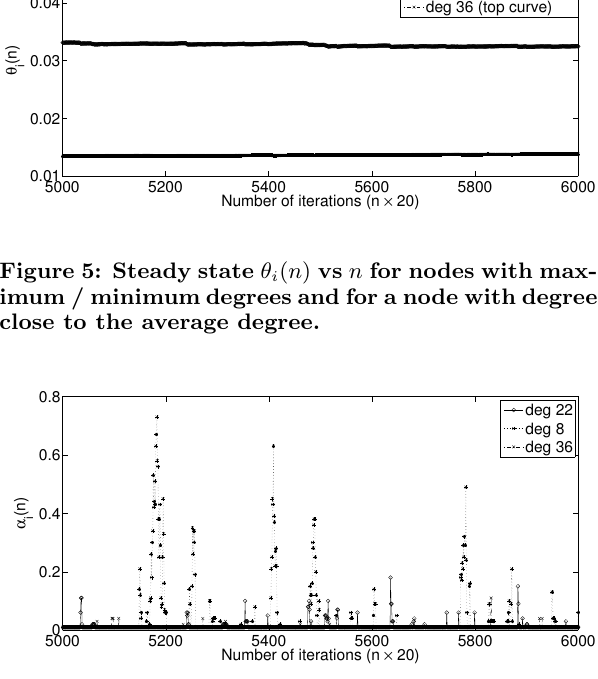
Figure 6: Steady state α i ( n ) vs n for nodes with maximum / minimum degrees and for a node with degree close to the average degree.